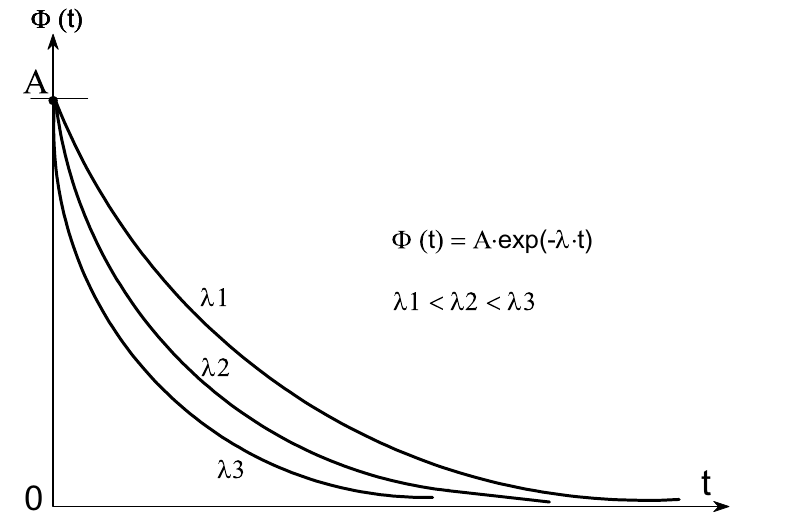
Fig. 2. Three realizations of an exponentially-decaying loading function of magnitude A and parameter λ , with λ 1 < λ 2 < λ 3 .